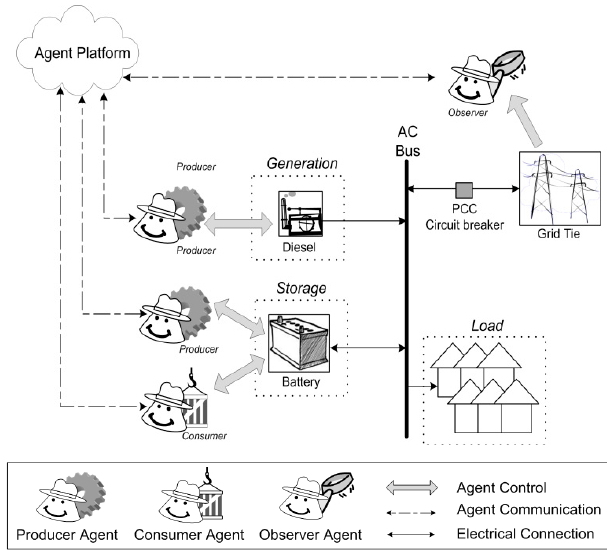
Figure 12. The two-asset MG. Table 3. MG